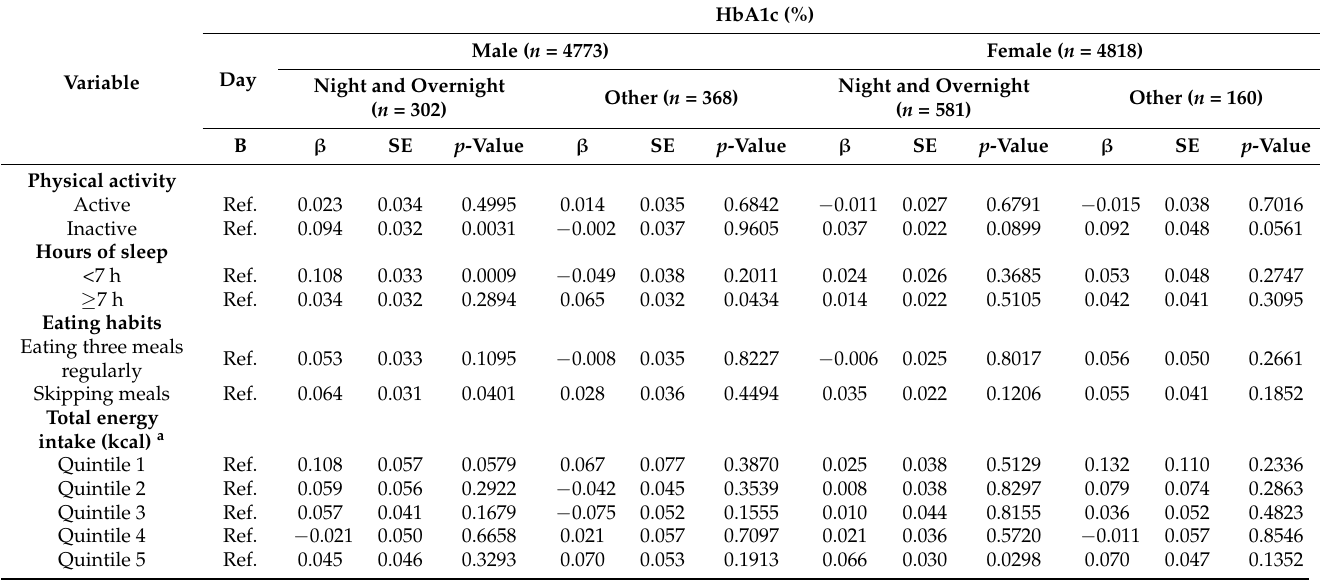
Table 3. Generalized multiple linear regression for HbA1c levels stratified by physical activity, hours of sleep, and daily eating.